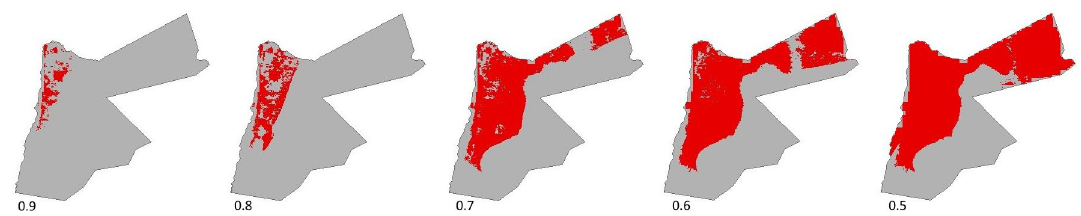
Fig 6. Geographic areas suitable for Phlebotomus papatasi occurrence using suitability cut-offs of 0.9 to 0.5.